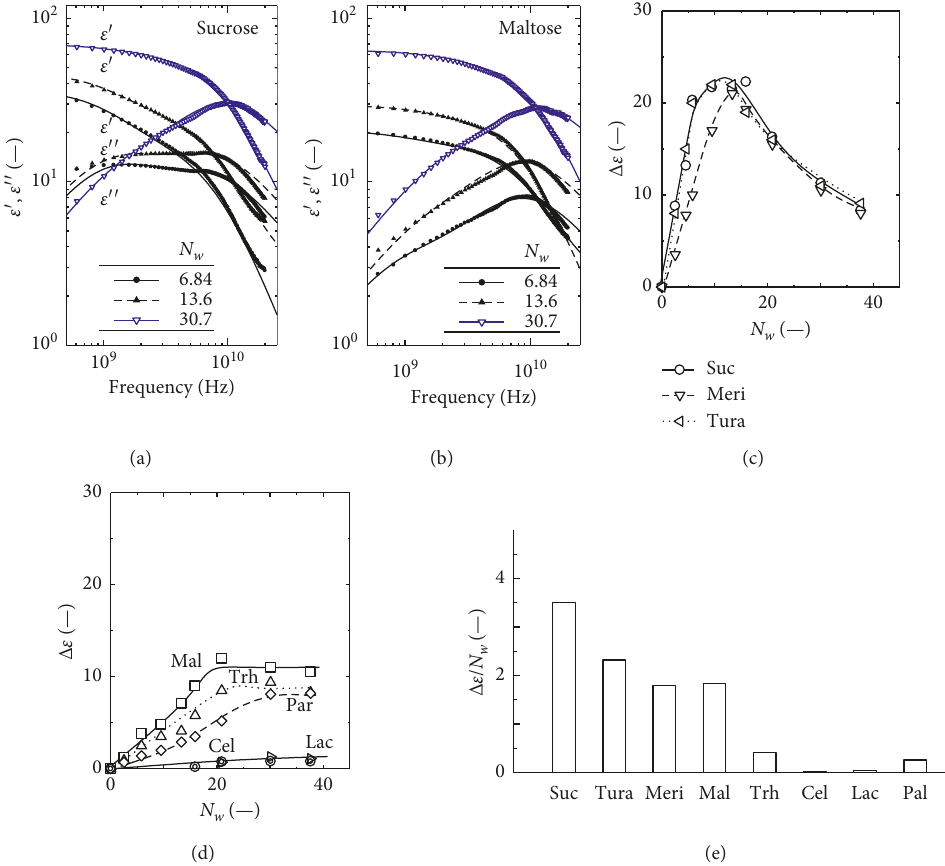
Figure 6: Dielectric spectra for (a) sucrose and (b) maltose in the frequency range between 500MHz and 20GHz. (c, d) The dielectric amplitude at first relaxation (at around 1–3 GHz) as a function of N w . (e) Hydration index for various disaccharides. Suc: sucrose; Tura: turanose; Meri: meribiose; Mal: maltose; Trh: trehalose; Cel: cellobiose; Lac: lactose; Pal: